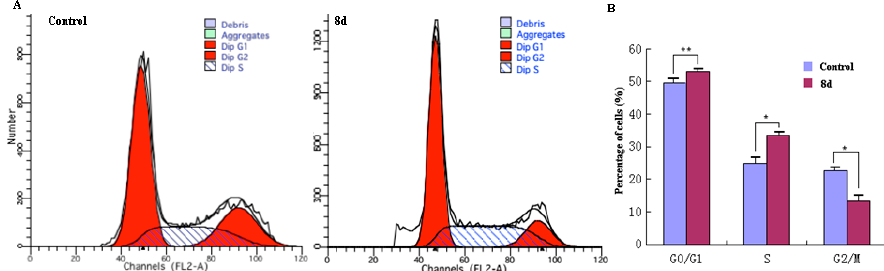
Figure 3. The effect of probe 8d on the HepG2 cell cycle. ( A ) Typical distribution of cell cycles treated with or without 8d (3 µ M). ( B ) Statistical analysis of cells distributed in each phase of cell cycles. * p < 0.05, ** p < 0.01.